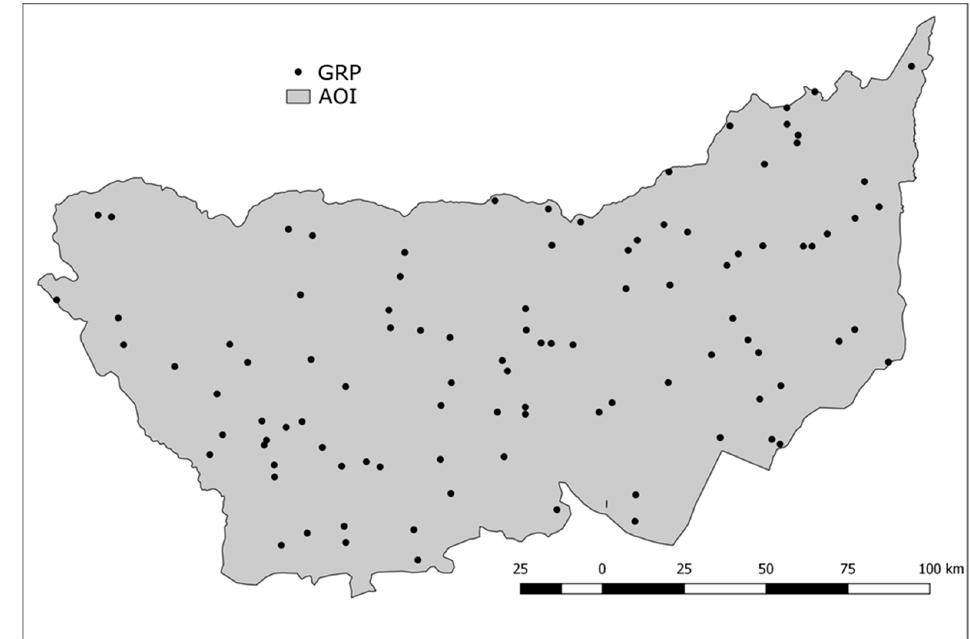
Figure 4. GRP distribution in the study area.